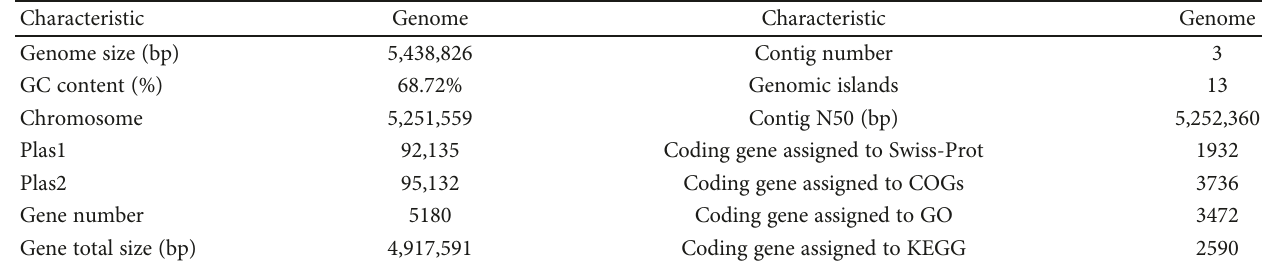
Table 2: Rhodococcus sp. DSSKP-R-001 genomic